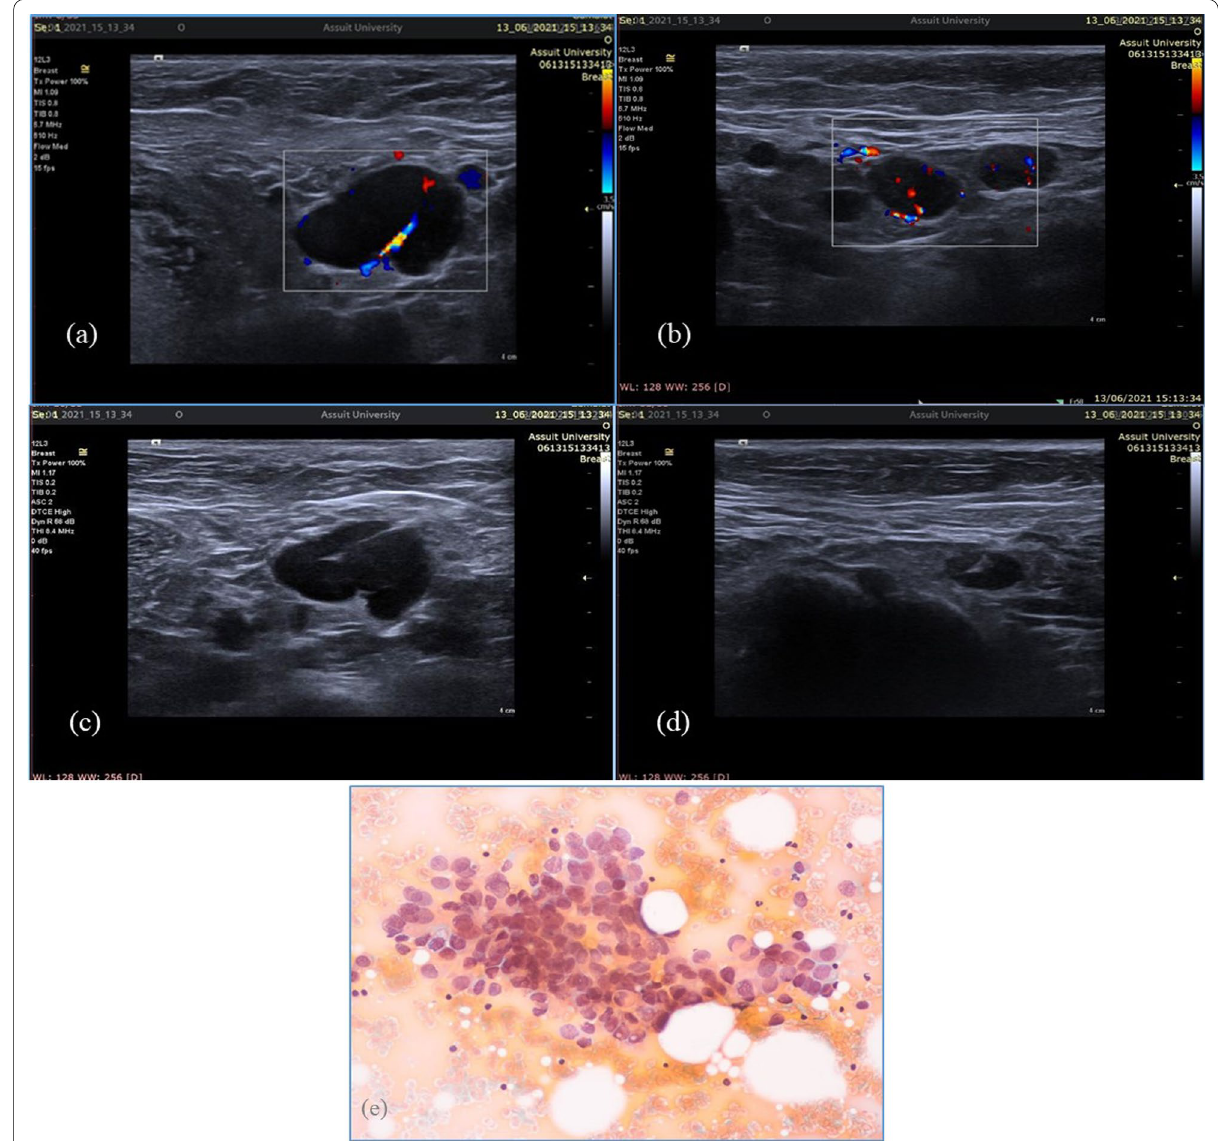
Fig. 2 An 48‑year‑old female patient, presented with breast cancer, and underwent fine‑needle aspiration cytology from the most two suspicious lymph nodes, Tru‑cut needle biopsy didn’t obtain in this case as suspicious lymph nodes were multiple and small in size, The final cytological evaluation showed metastatic lymph nodes harboring malignancy. a , b Axillary ultrasound with Doppler shows multiple suspicious lymph nodes, the largest was oval in shape and measures about 21 12 mm, with effaced hilum. The other nodes are round in shape the and largest of them × measuring about 10 9 mm. On color Doppler, the lymph nodes showed both hilar vascular flow in addition to some cortical non‑hilar blood × flow at the periphery. c , d show FNA needle arrows while traversing the cortex of both lymph nodes, in which histopathological analysis revealed metastatic malignant cells of both aspirated nodes. e Photomicrograph of the largest lymph node cytology smear: clusters of malignant epithelial cells on hemorrhagic (Papanicolaou stain,